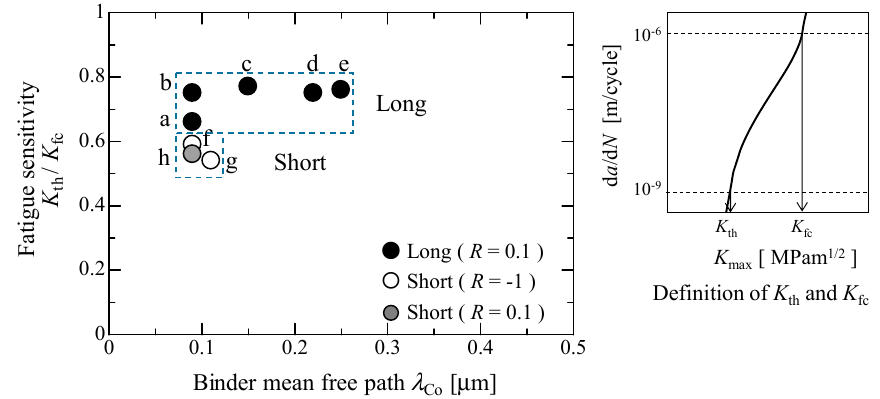
Figure 14. Fatigue sensitivity and microstructure relationship for fine-grained WC-Co Figure 14 Fatigue sensitivity and microstructure relationship for fine-grained WC-Co cemented cemented carbides. carbides. Figure 14 Fatigue sensitivity and microstructure relationship for fine-grained WC-Co cemented Figure 14 Fatigue sensitivity and microstructure relationship for fine-grained WC-Co cemented Figure 14 Fatigue sensitivity and microstructure relationship for fine-grained WC-Co cemented Figure 14 Fatigue sensitivity and microstructure relationship for fine-grained WC-Co cemented Figure 14 Fatigue sensitivity and microstructure relationship for fine-grained WC-Co cemented carbides. carbides. carbides. Figure 14 Fatigue sensitivity and microstructure relationship for fine-grained WC-Co cemented carbides. Table 3. Microstructural properties and fatigue-testing conditions for several fine-grained cemented Table 3. Microstructural properties and fatigue-testing conditions for several fine-grained carbides. Figure 14 Fatigue sensitivity and microstructure relationship for fine-grained WC-Co cemented carbides. Table 3. Microstructural properties and fatigue-testing conditions for several fine-grained cemented carbides. cemented carbides. Table 3. Microstructural properties and fatigue-testing conditions for several fine-grained cemented Table 3. Microstructural properties and fatigue-testing conditions for several fine-grained cemented Figure 14 Fatigue sensitivity and microstructure relationship for fine-grained WC-Co cemented carbides. Table 3. Microstructural properties and fatigue-testing conditions for several fine-grained cemented Table 3. Microstructural properties and fatigue-testing conditions for several fine-grained cemented carbides. carbides. carbides. Table 3. Microstructural properties and fatigue-testing conditions for several fine-grained cemented carbides. carbides. Table 3. Microstructural properties and fatigue-testing conditions for several fine-grained cemented carbides. Table 3. Microstructural properties and fatigue-testing conditions for several fine-grained cemented carbides. carbides.